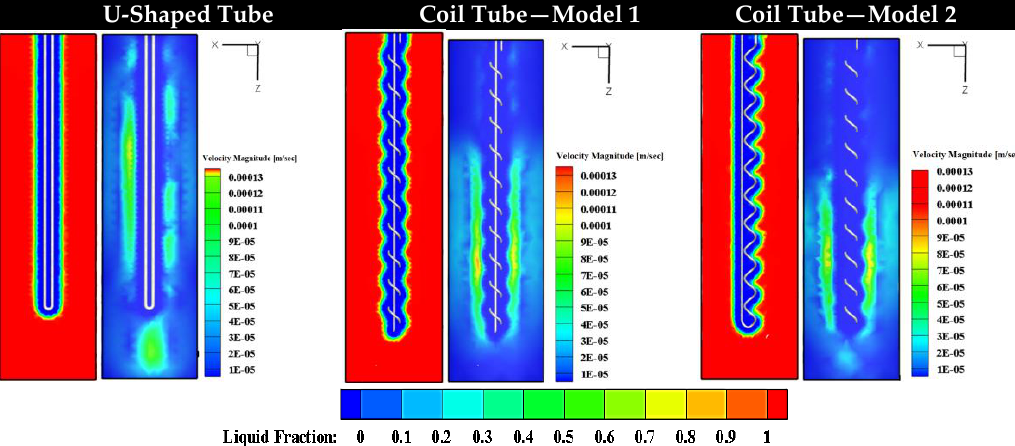
Figure 12. Contours of liquid fraction and velocity magnitude (m / s) for three types of tube in the vertical position after 14 h and at midplane Y = 0.